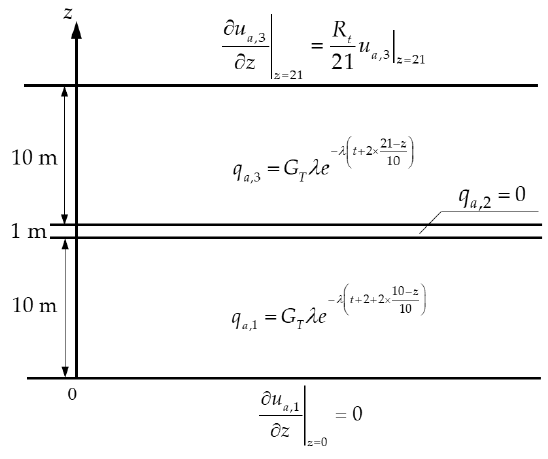
Figure 4. Illustration of a landfill containing two layers of MSW and an intermediate